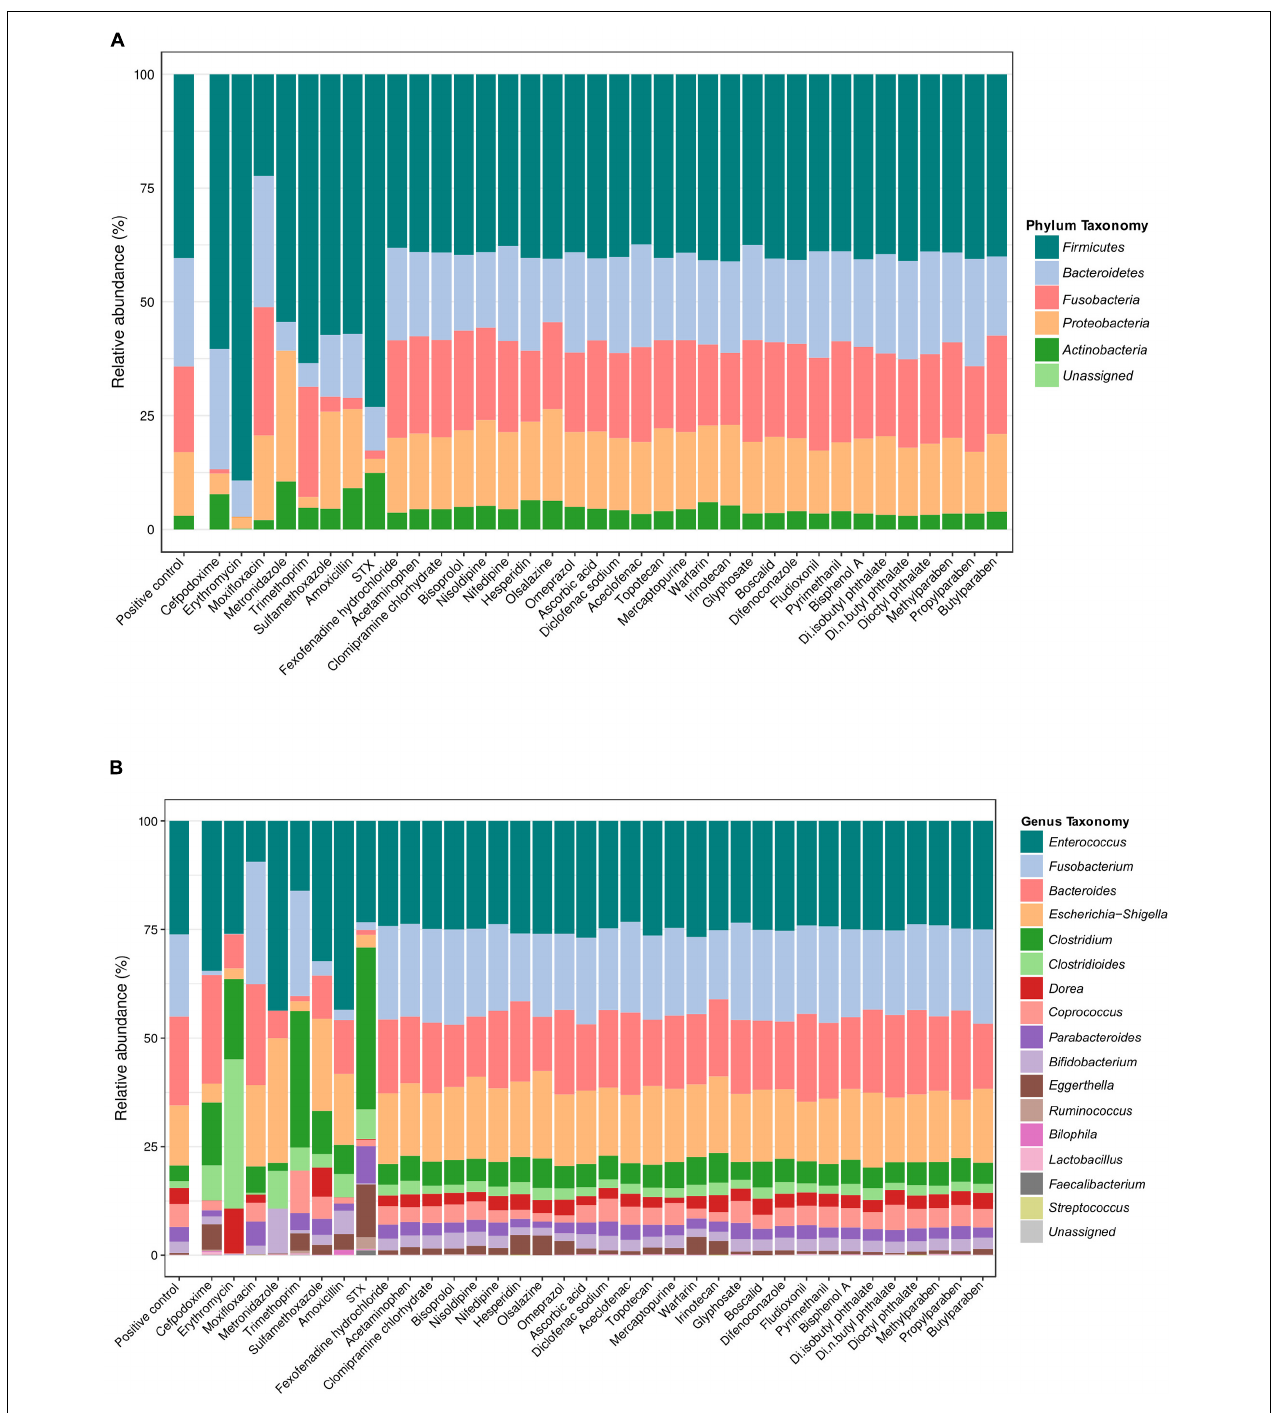
FIGURE 3 | Relative abundances of the HGMM bacterial community in presence of antibiotics, drugs and xenobiotics. (A) Barplots showing the relative abundances of the HGMM bacterial community at the phylum level and (B) at the genus level following the 48 h of incubation in the presence of the molecules and compared to the HGMM control cultures without molecule